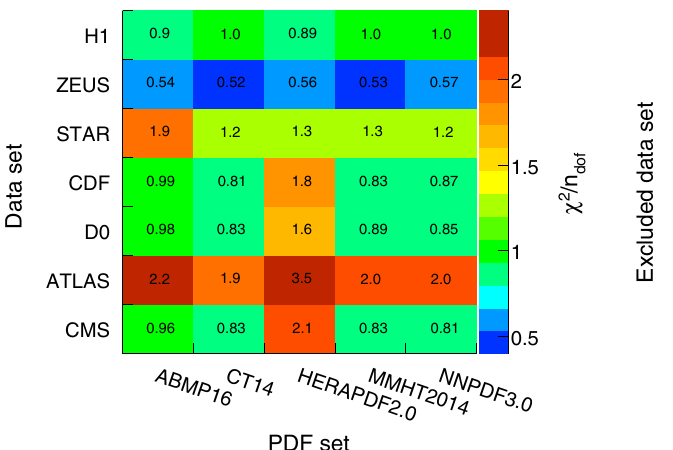
tion, which is not necessarily consistent with the value of ( M ) used in the pQCD calculation. It is calculated α s Z as the maximal difference between any of the results obtained with PDF sets determined for α PDF 0 . 1170, 0 . 1180, and 0 . 1190, and therefore covers a differ- ( M ) = 0 . 0020, which is somewhat more ence of Δα PDF Z s conservative than the recommendation in Ref. [101].